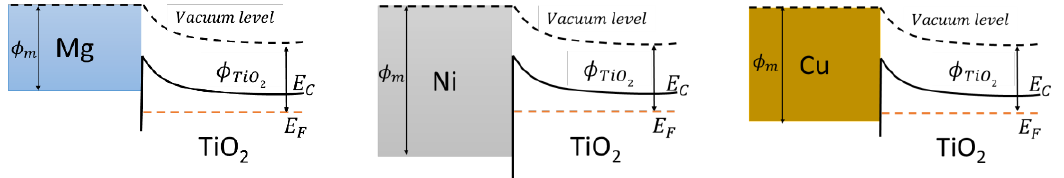
Figure 10. The alignment of the electron work function of metal dopants ( Φ m ) and titanium dioxide ( Φ TiO2 ).